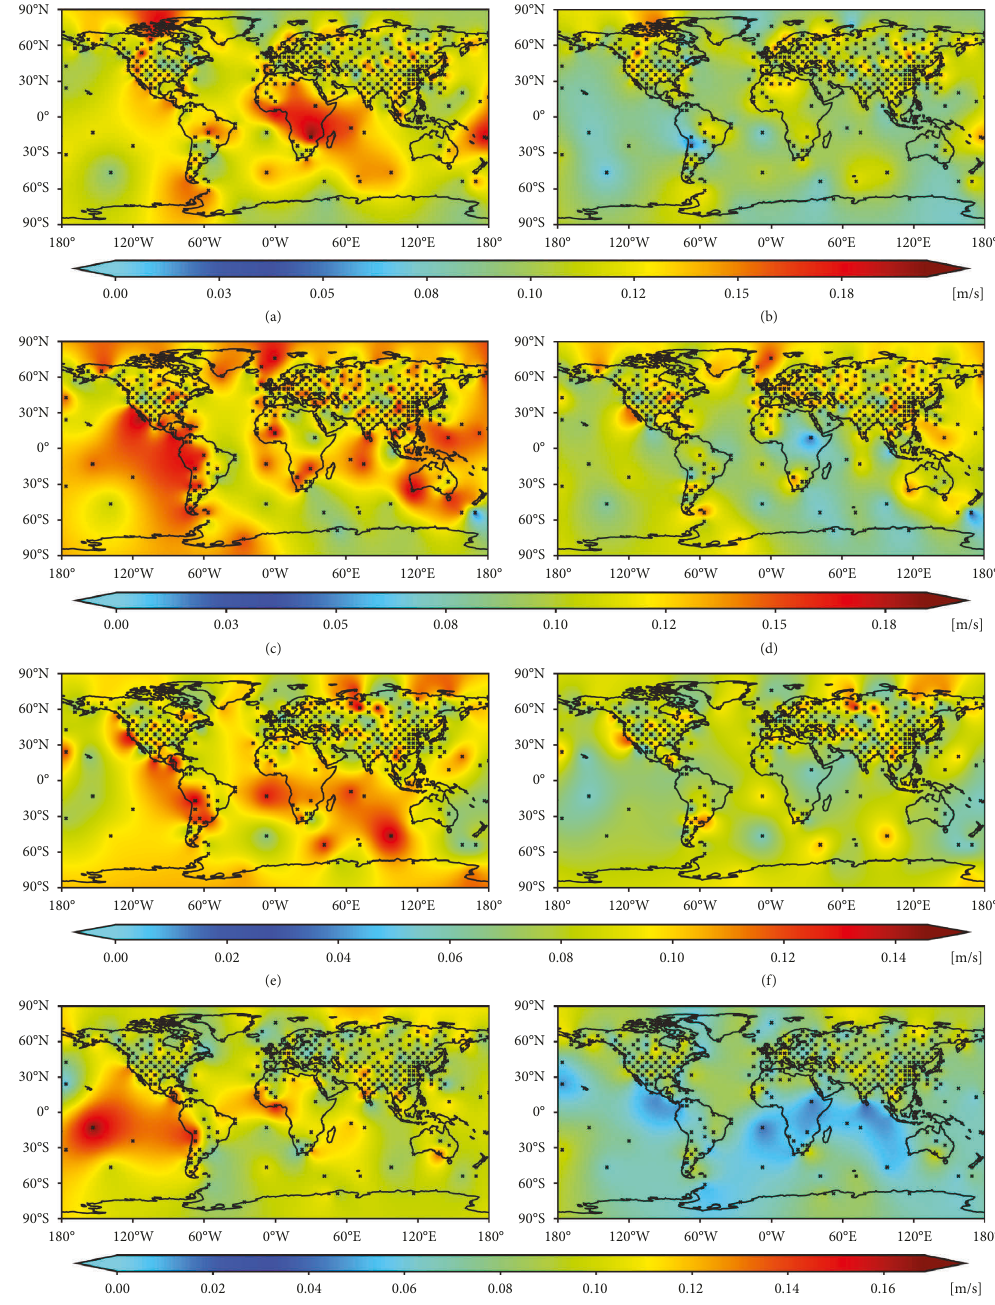
Figure 6: The spatial distributions of the time-mean analysis RMSEs for zonal wind from 0000UTC 1 March 1982 to 0000 UTC 1 April 1982 with different ensemble sizes, and (a), (b) ensemble size � 75; (c), (d) ensemble size � 100; (e), (f) ensemble size � 125; (g), (h) ensemble size � 200. (a), (c), (e), and (g) refer to the analysis result from the CL, and (b), (d), (f), and (h) refer to the analysis result from the CL-MC. The × symbols indicate the observation